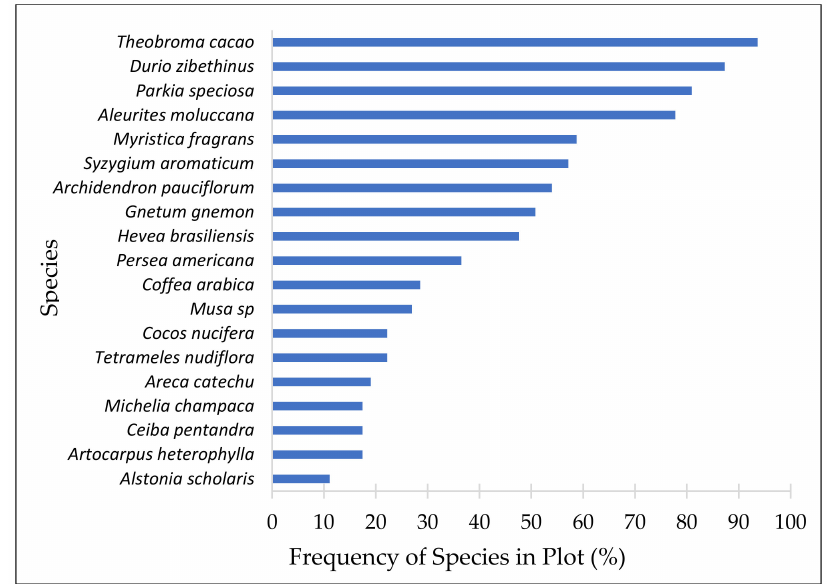
Figure 4. Frequency of species in the 63 managed plots (%) in WAR GFP.